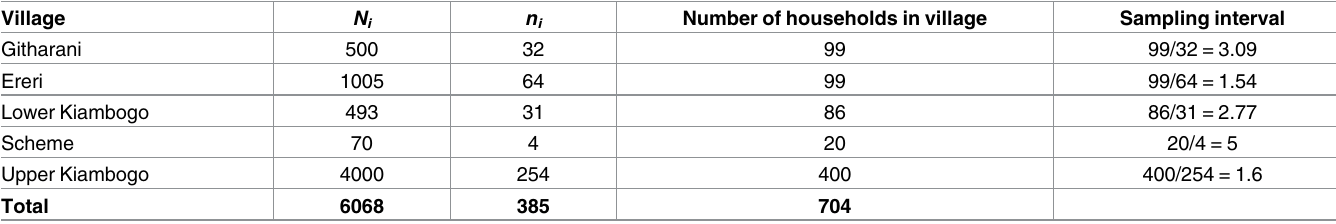
Table 1. Sampling distribution by